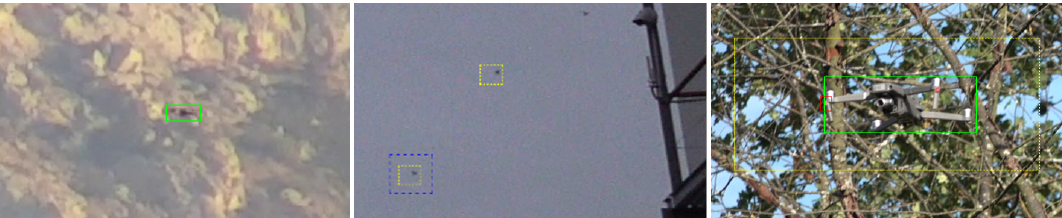
Figure 24. Images crops showing qualitative detection results and the corresponding GT (green). Note that the detection results from Team Alexis (red), Team Eagledrone (blue) and Team Gradient (yellow) are enlarged to simplify the visualization. Remaining challenges are mainly small drones in front of structured backgrounds, small disturbing objects and drones in front of unseen structured